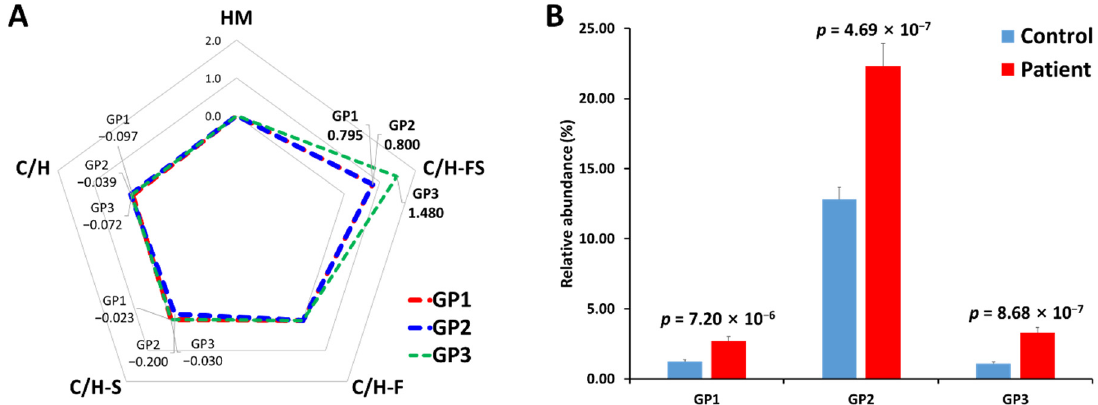
Figure 5. Comparison of N-glycosylation on haptoglobin between the healthy control and gastric cancer patient samples. ( A ) The radar chart of log 2 fold changes (the ratio of cancer to control) for glycan classes of each glycopeptide group. ( B ) The relative abundance and p -value of glycoforms with both fucosylation and sialylation. HM—high mannose type; C/H—complex/hybrid type without fucose or sialic acid; C/H-S—complex/hybrid type with only sialic acid; C/H-F— complex/hybrid type with only fucose; C/H-FS—complex/hybrid type with fucose and sialic acid.